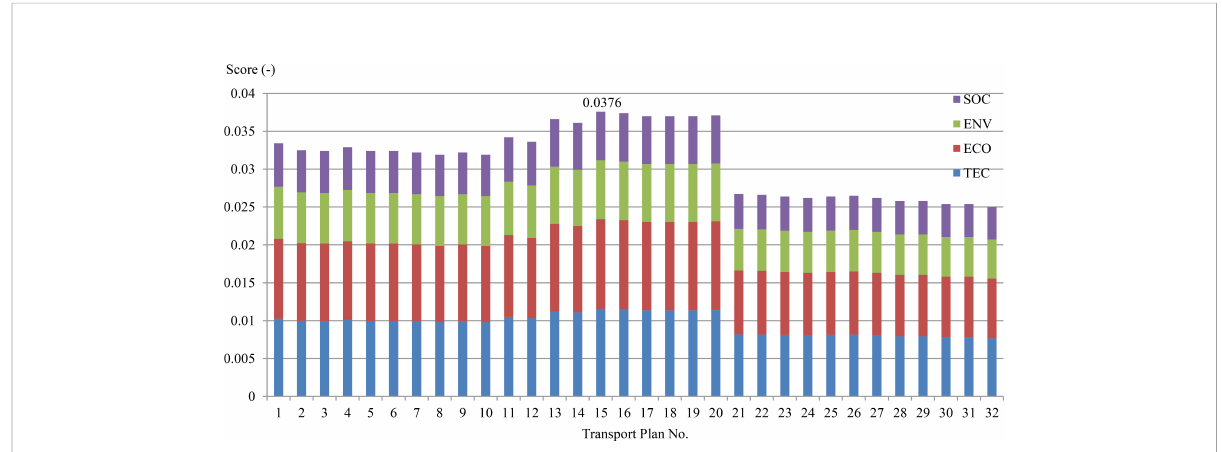
FIGURE 6 Diagrammatic representation of the evaluated DSM transport plan scores. Note: Transport plan (TR) No. 15 represents the maximum score and is marked in the fi gure with a score of 0.0376. TRs. No (1-10), (11-20) and (21-32) are CLB, HL and AL systems,